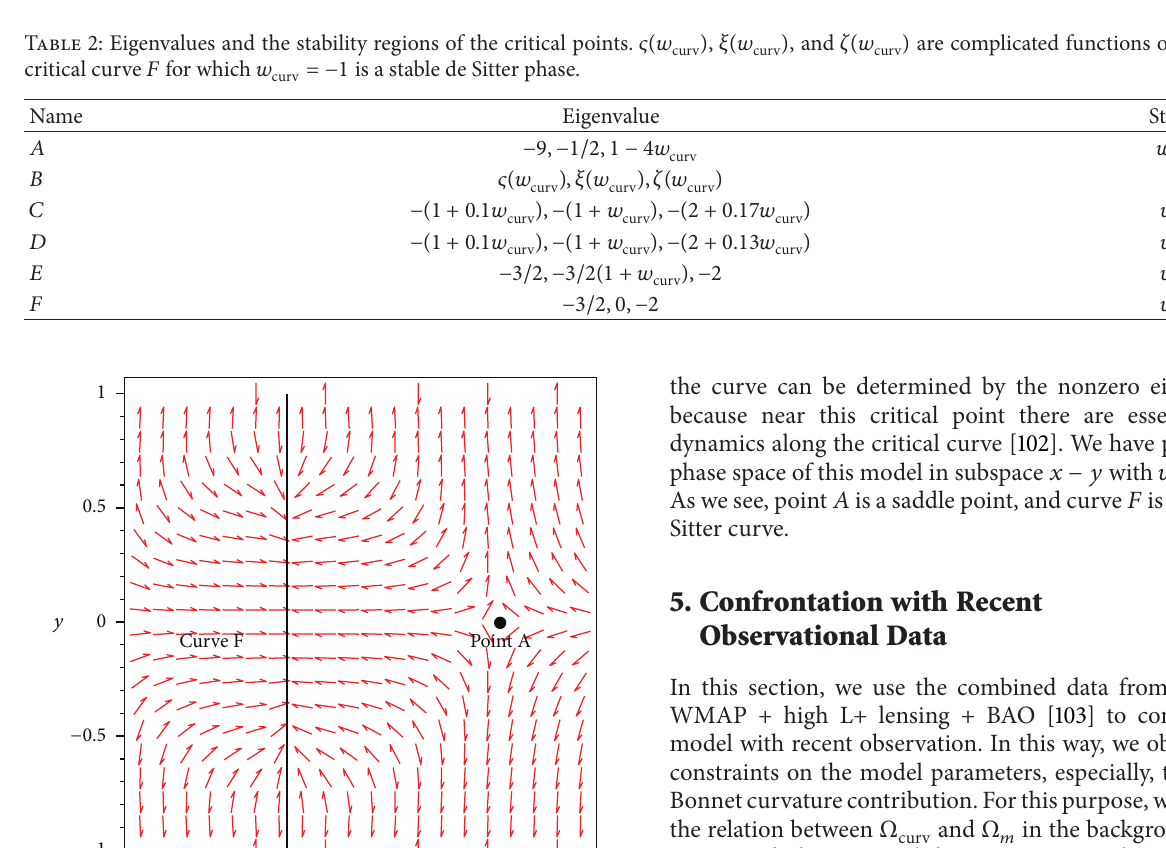
Table 1: Location and deceleration parameter of the critical points. The location of point 𝐵 and the deceleration factor of points 𝐶 and 𝐷 are dependent on the equation of state parameter of the perfect fluid, 𝑤